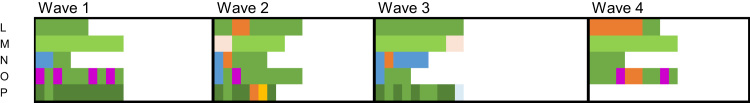
Examples of non-stable but patterned behaviour. Each horizontal line is an individual. The waves are separated by vertical black lines. Each trip is one square, individually colour-coded and the length of the line corresponds with the number of commute trips made over one week. Each colour represents one modal combination. Orange = car only; green = bicycle only; blue = walk only; yellow = train only; and brown = bus only. The white colour indicates no trip was made. Full legend: see Appendix D. (For interpretation of the references to color in this figure legend, the reader is referred to the web version of this article.)